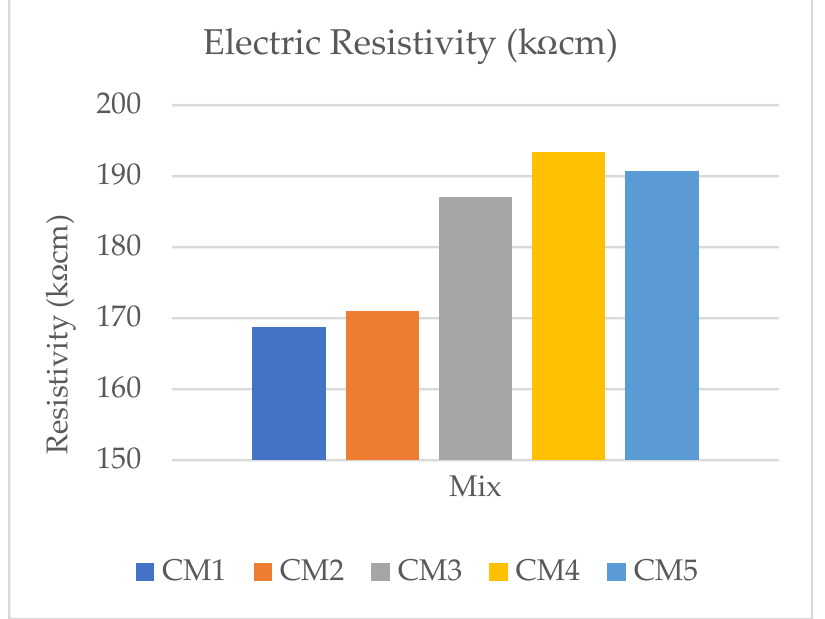
Figure 15. Electric resistivity of CM-UFS-GO composites.